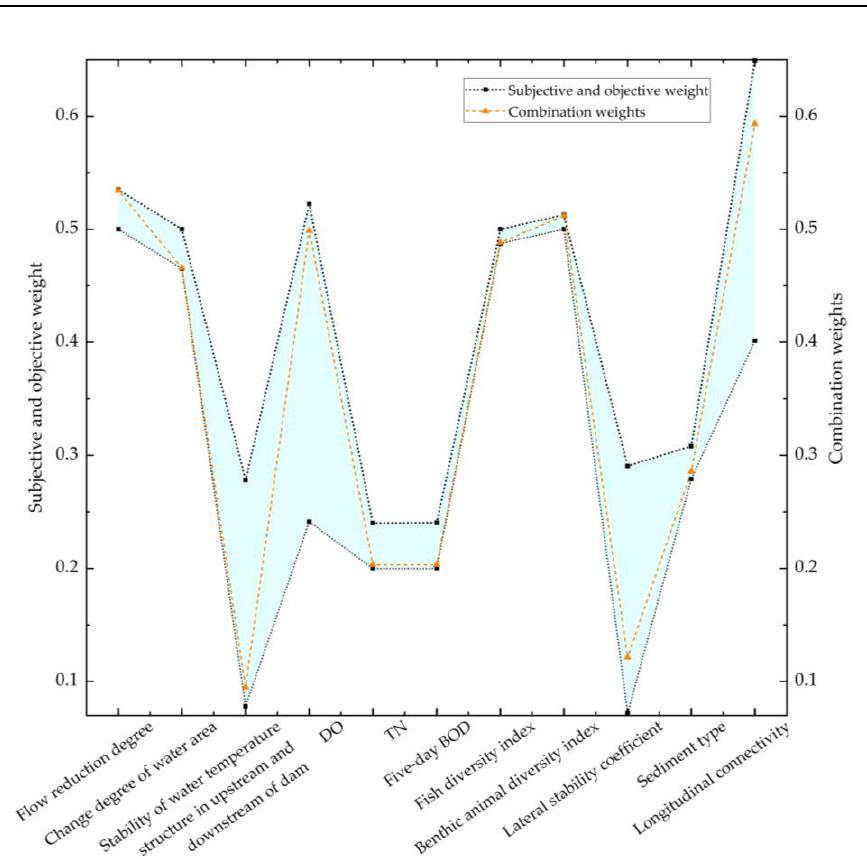
Figure 2. Weight calculation results of Tufang River assessment index (2018).